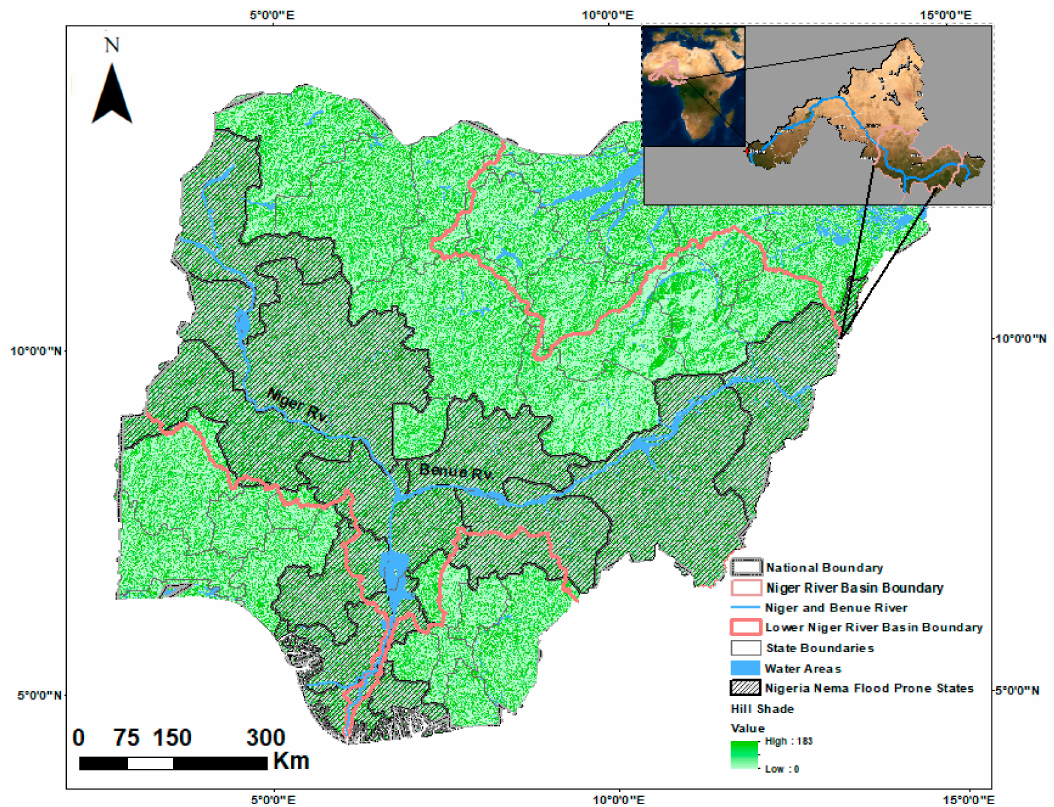
Figure 1. Map showing the boundaries of the Lower Niger River Basin in Nigeria with the states prone to Flooding (Nigeria National Emergency Management